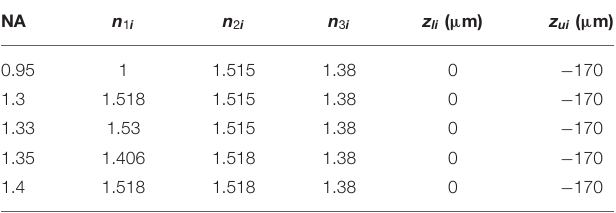
TABLE 1 | Parameters in the ideal